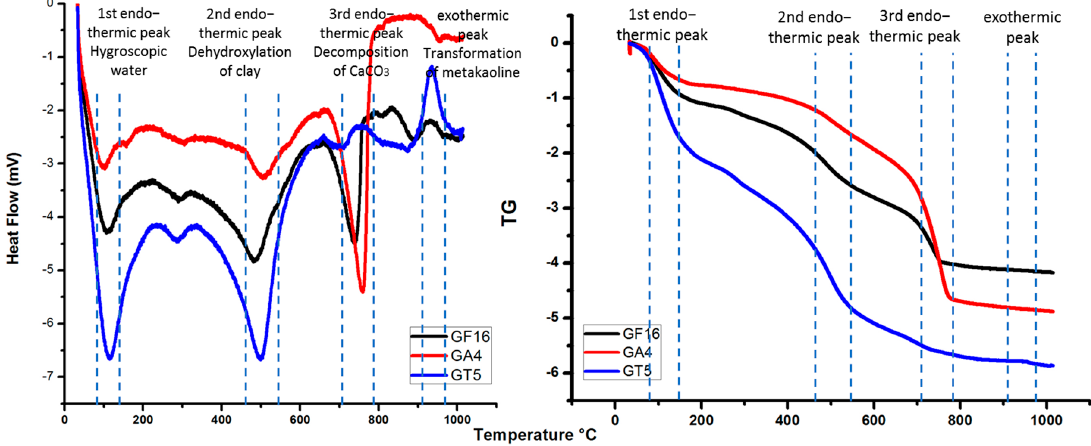
Figure 9. DTA-TG analysis of GA4, GT5 and GF16.